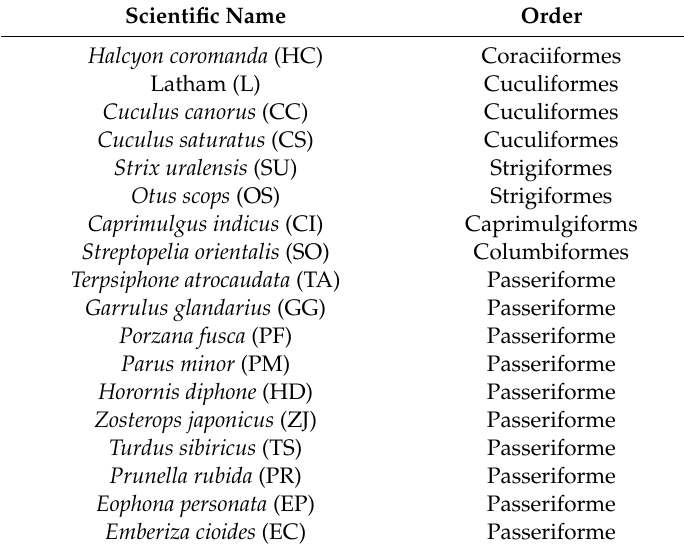
Table 1. Birdsong stimuli used in this